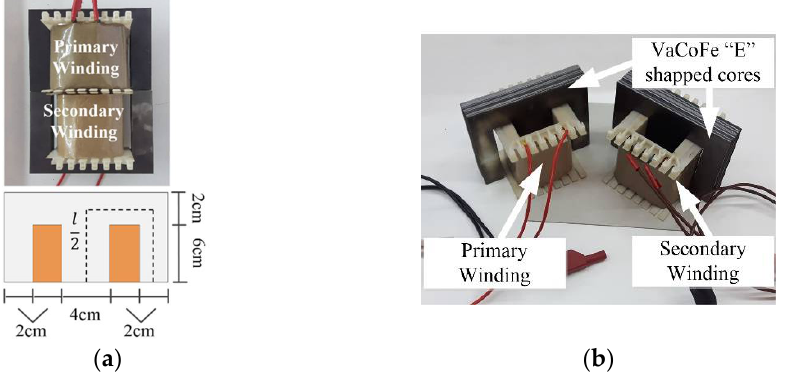
Figure 1. Magnetic circuit used in the experimental tests made from VaCoFe. ( a ) Magnetic circuit dimensions with half of the average path, l , (dashed line), and ( b ) core and windings’ identification.